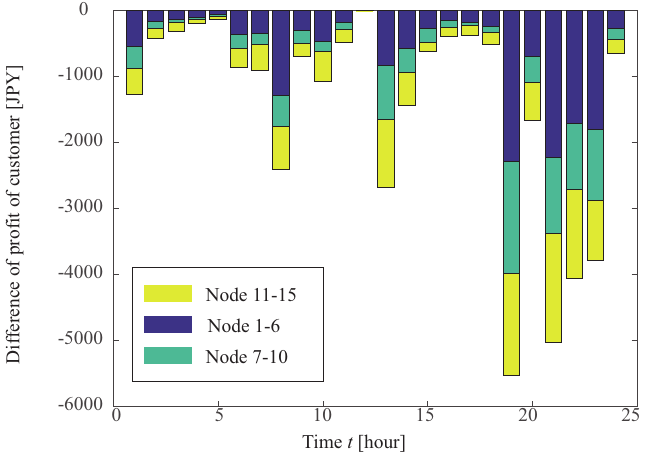
Figure 16. A comparison of hourly profit with contribution functions (= κ sig − κ lin ) in the cooperative condition (participation rate is